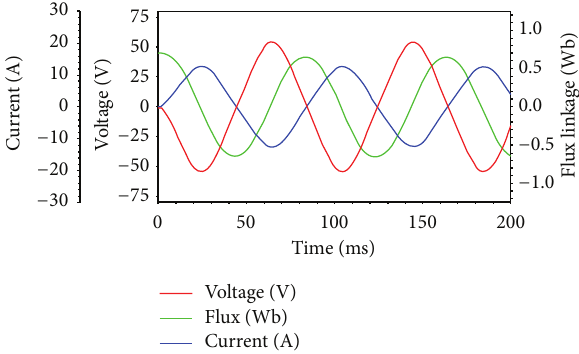
Figure 12: Different forces of the PMLG.